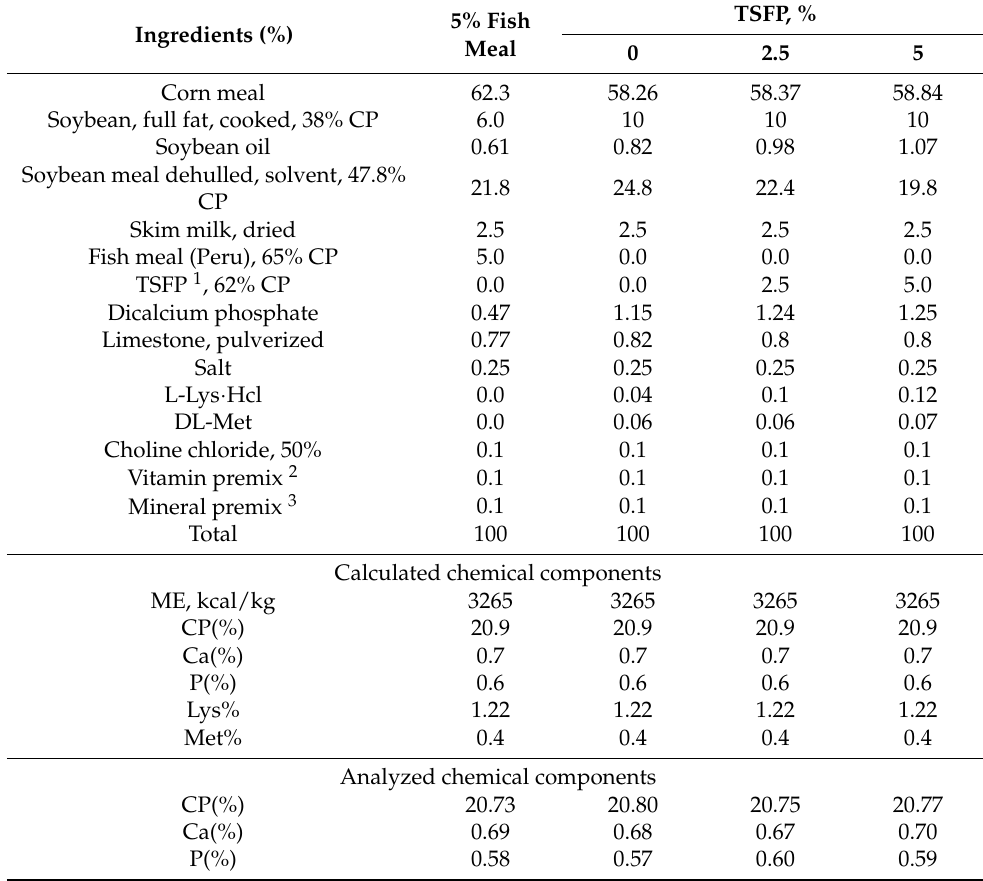
Table 2. Composition of experiment diets (as-fed basis) (trial